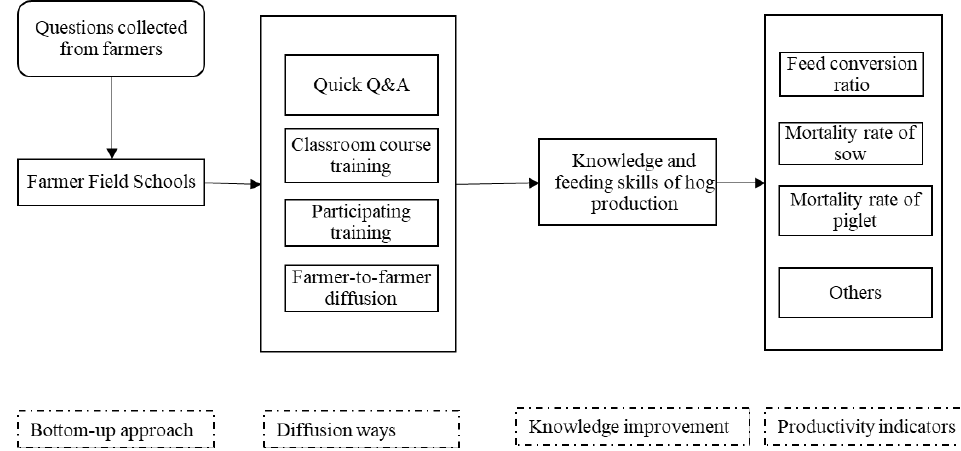
Figure 1. Influence mechanism of FFS on hog production.